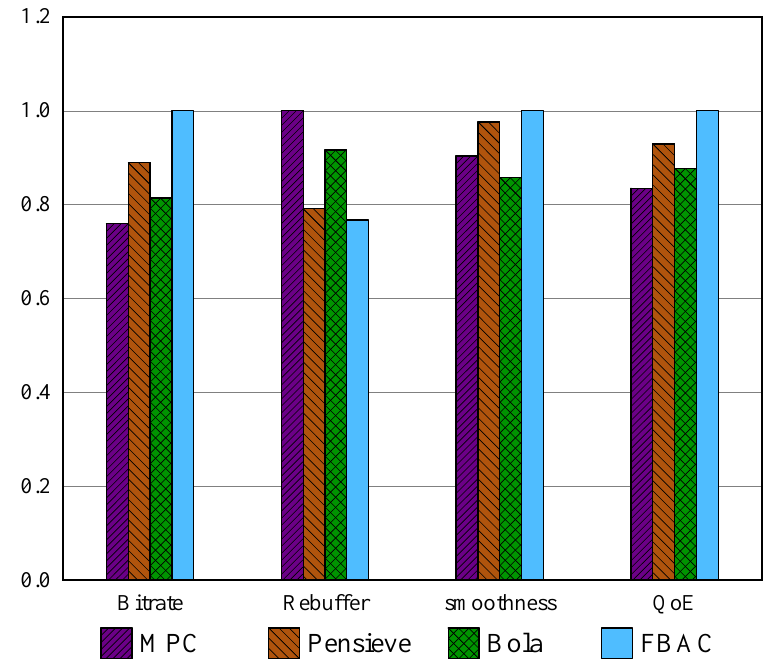
Figure 6. Various indicators of QoE in dynamic bandwidth scenarios.